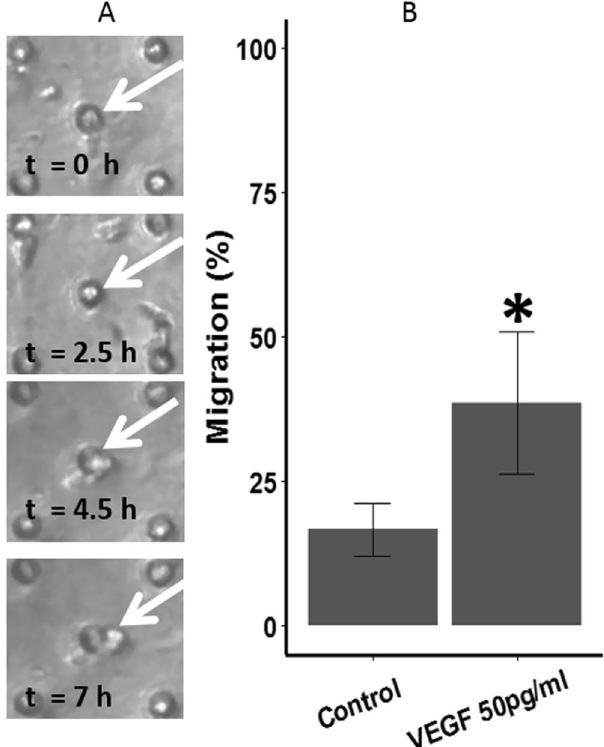
Figure 3. ( A ) Snapshots of HUVEC migrating through the porous membrane taken at different time points. ( B ) Migration (%) of HUVEC at VEGF-free and with VEGF added to the upper channel. Data sets were analysed using Student’s t-test with the asterisk * indicated a significant difference found between the groups ( * p = 0.035, n =